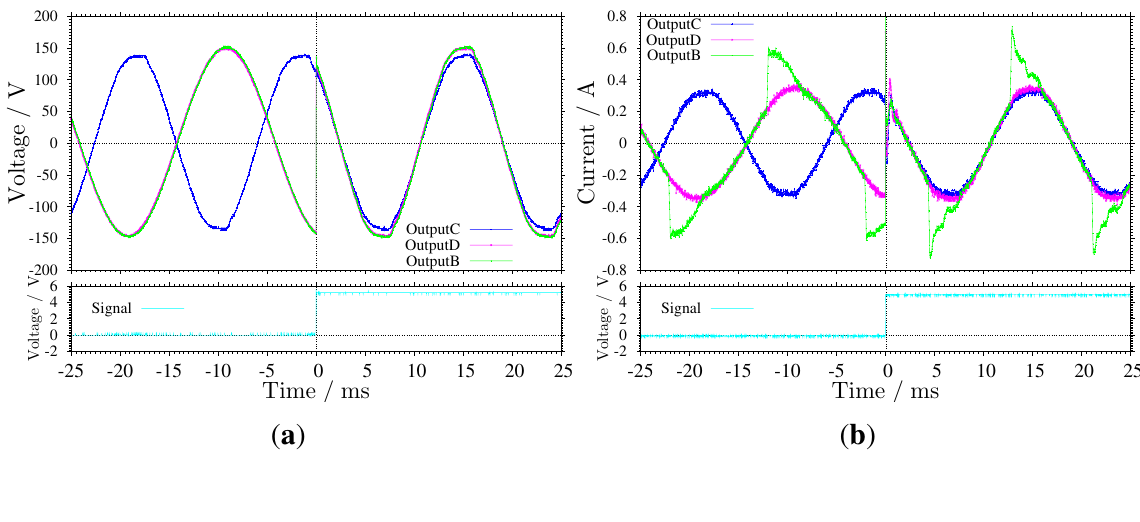
Figure 10. Output waveforms in a series connection when the upstream power router #1 exchanges lines: ( a ) output voltage waveforms; and ( b ) output current